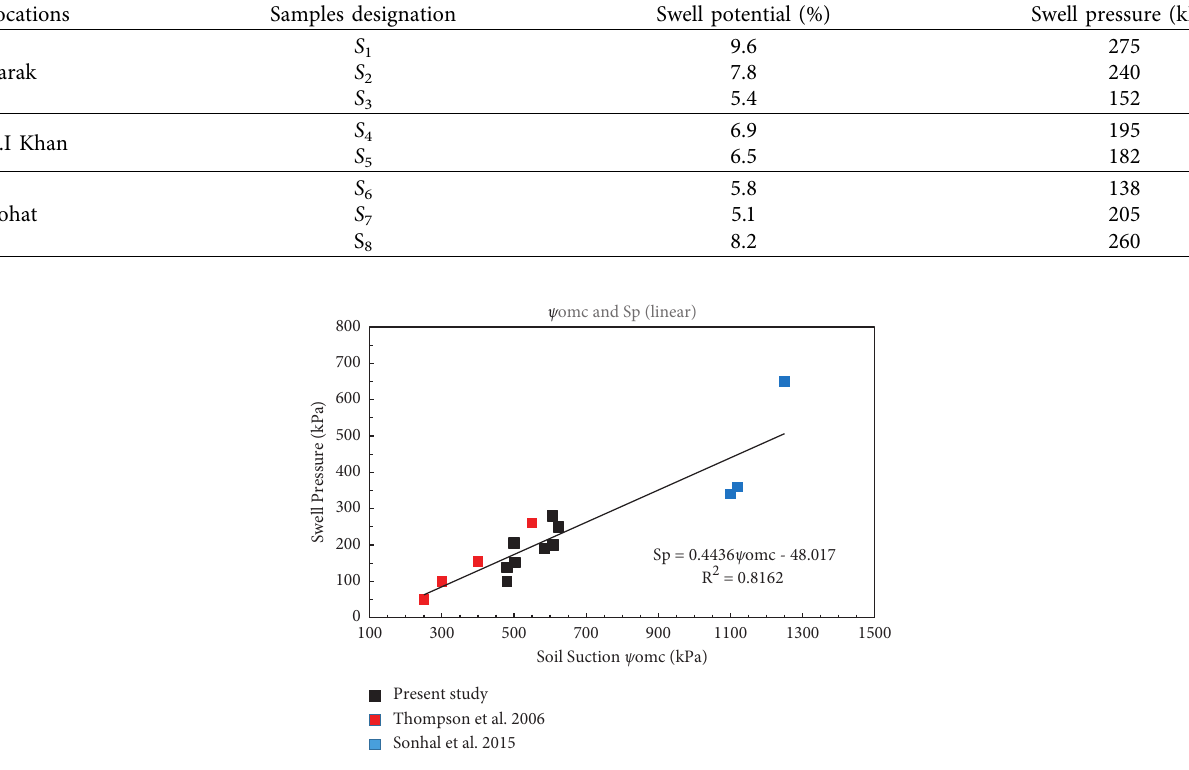
Figure 5: Presentation of novel suction-based linear correlation for swell